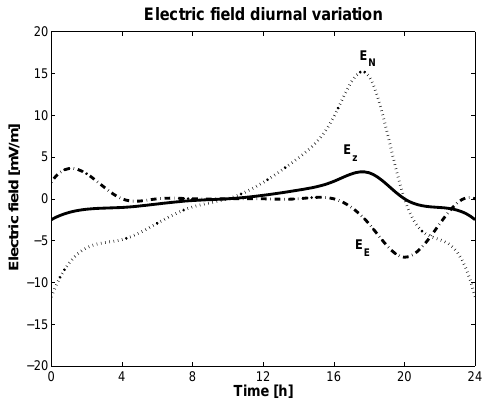
Fig. 2. Electric field components diurnal variations: E N (merid- ional): dotted, E E (zonal): dash-dotted, E z (vertical): continuous line.